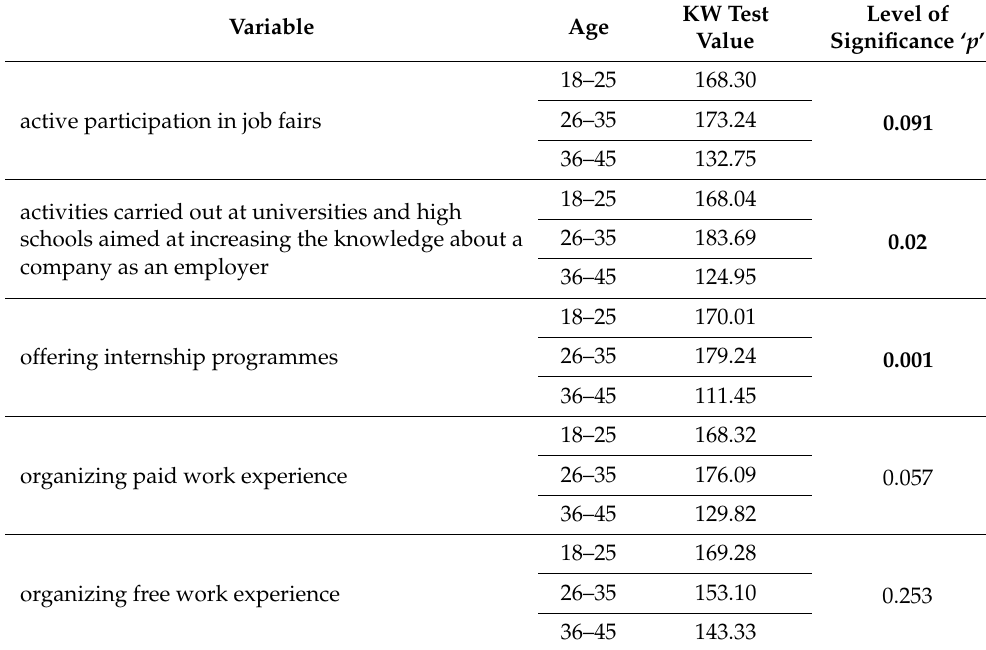
Table 6. The significance of differences between responses concerning activities undertaken by enterprises depending on the age of